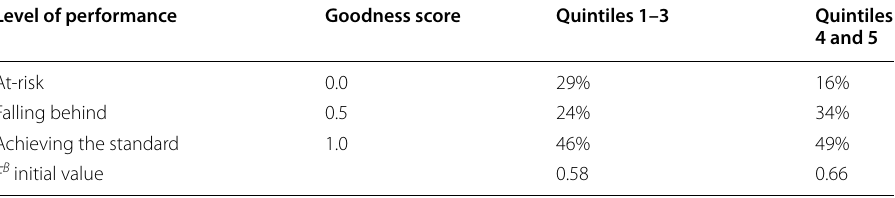
Table 10 Average percentage of children at each level of aptitude per socio-economic quintile Level of performance Goodness score